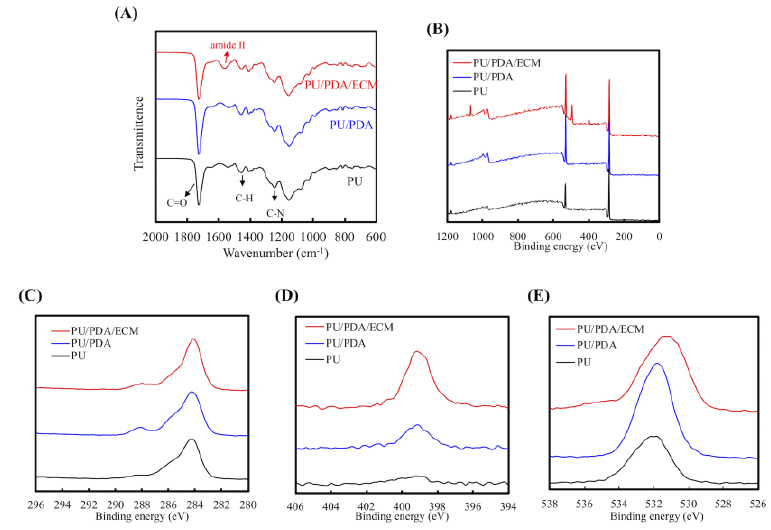
Figure 4. ( A ) FTIR spectra, ( B ) XPS, ( C ) C1s, ( D ) N1s, and ( E ) O1s high-resolution spectra of PU, PU/PDA, and PU/PDA/ECM composites.